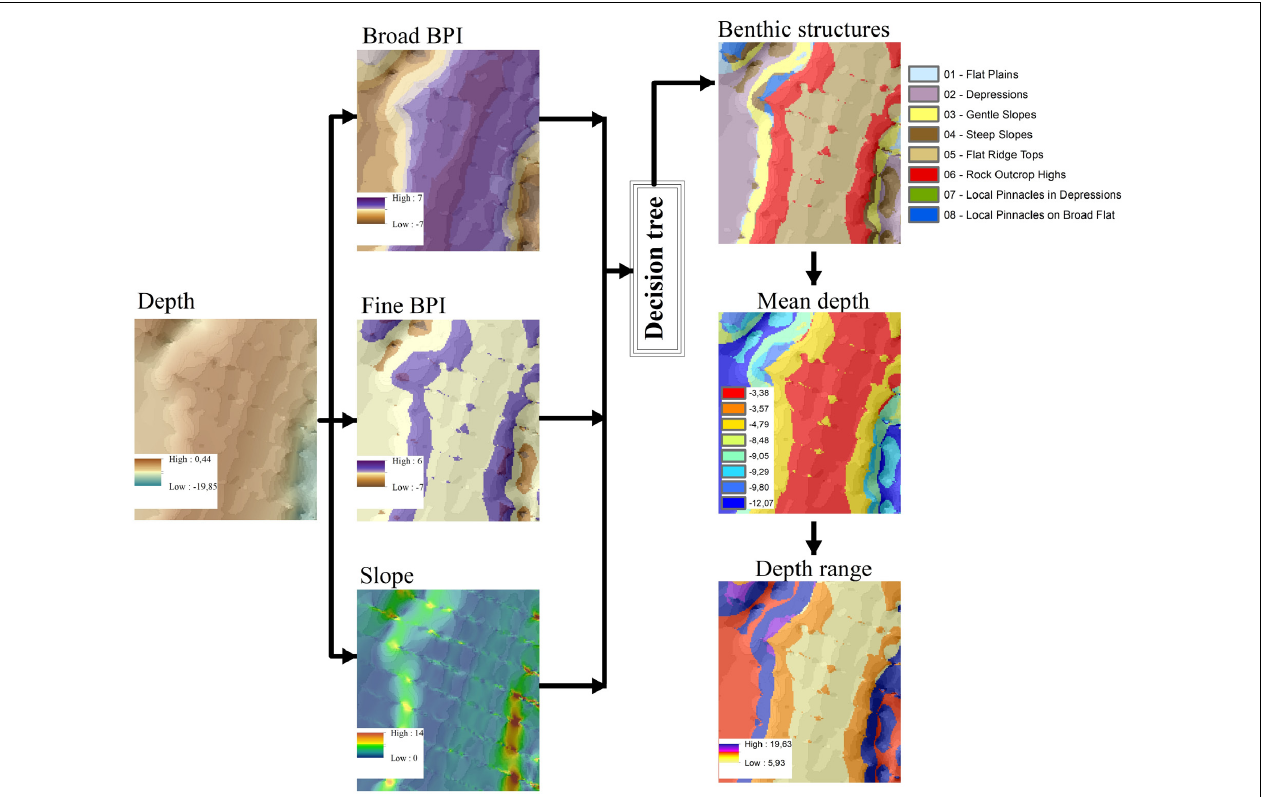
FIGURE 2 | Flow chart of morphology classification scheme using terrain attributes for the study area. The final products (last image column) represent the topographical characteristics based on bathymetry and derived products (BPIs and